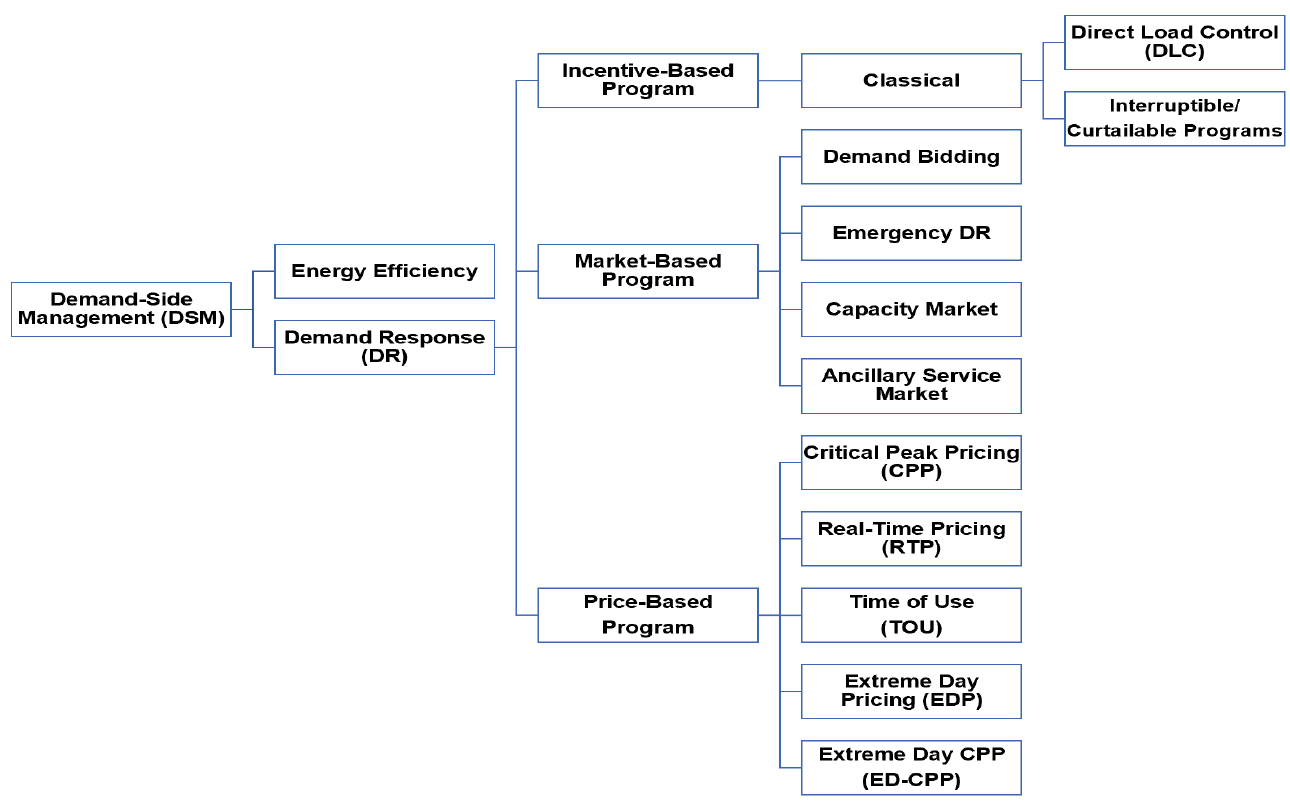
Figure 1. Classification of Demand-Side Management